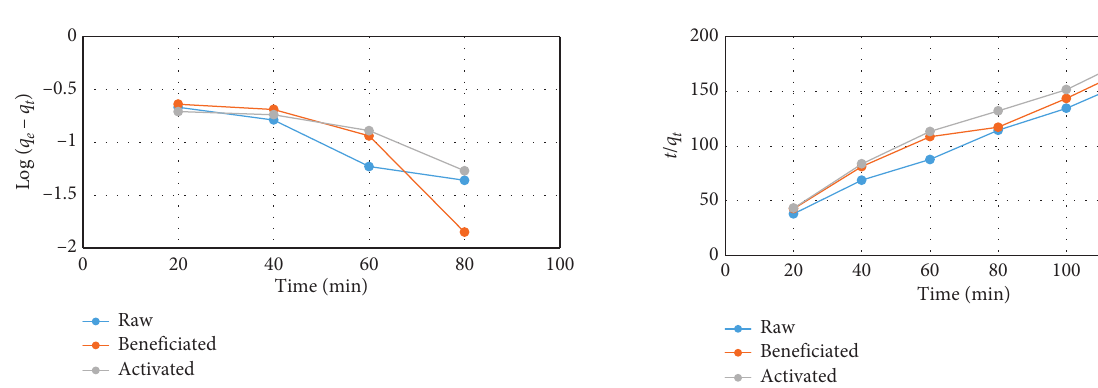
Figure 10: Pseudo-second-order kinetics model for all adsorbents at 50mL of 25 mg/L of MB